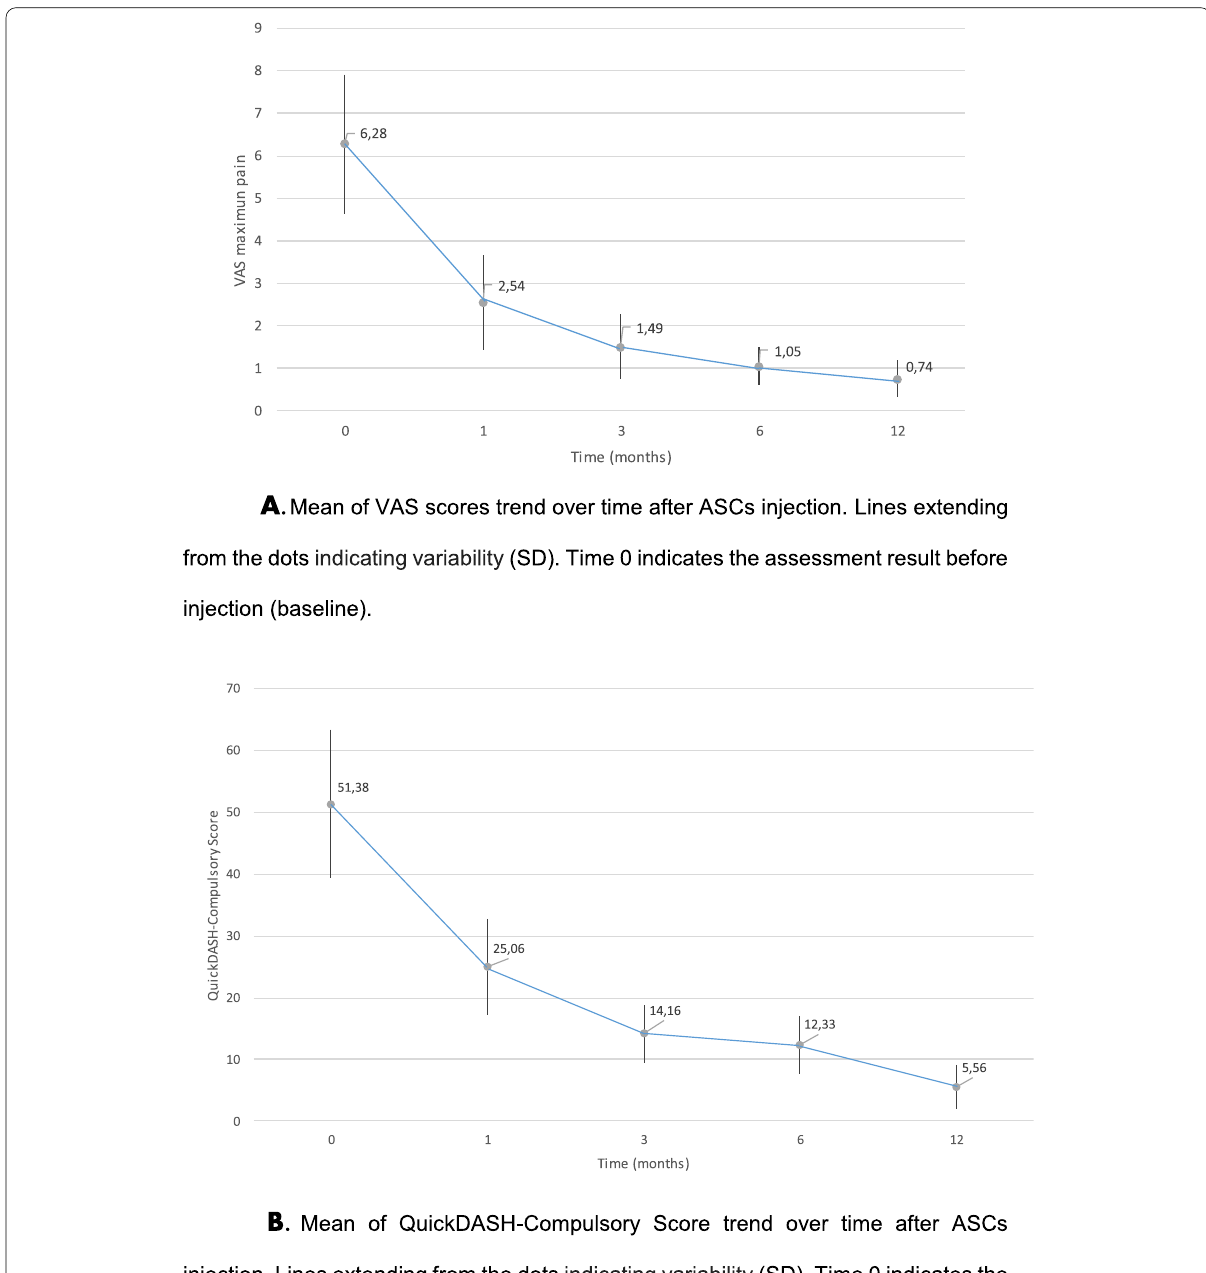
Fig. 1 a Mean of VAS scores trend over time after ASCs injection. Lines extending from the dots indicating variability (SD). Time 0 indicates the assessment result before injection (baseline). b . Mean of QuickDASH-Compulsory Score trend over time after ASCs injection. Lines extending from the dots indicating variability (SD). Time 0 indicates the assessment result before injection